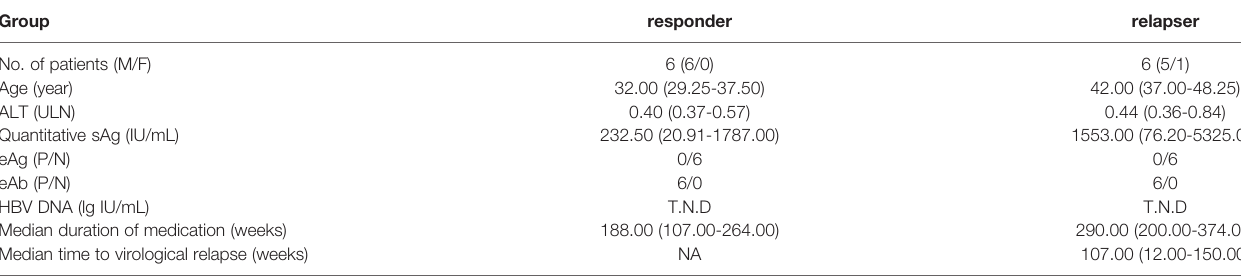
TABLE 2 | Clinical characteristics of responders and relapsers with chronic HBV infection at the end of treatment. Group